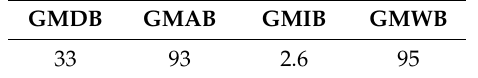
Table 1. Prices of GMxB guarantees (in bp) calculated via Monte Carlo (MC)